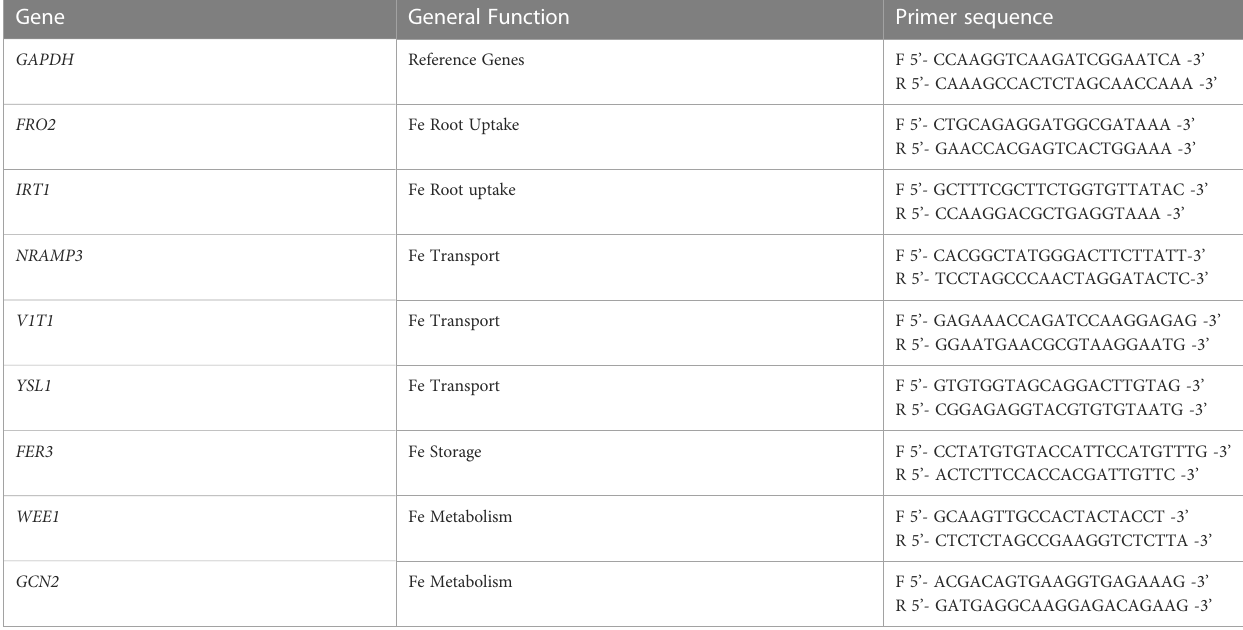
TABLE 2 Name and general function of selected genes involved in Fe metabolism along with the forward and reverse primer sequences used in qPCR analysis. Gene General Function Primer sequence